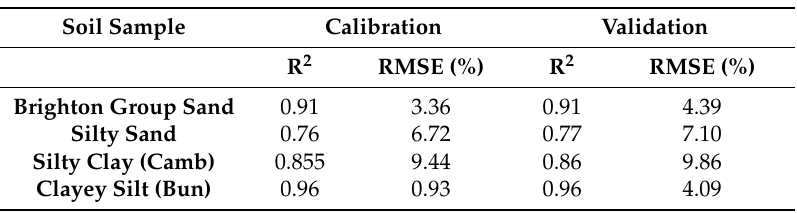
Table 7. Cross validation analysis for the PCB Sensor for each